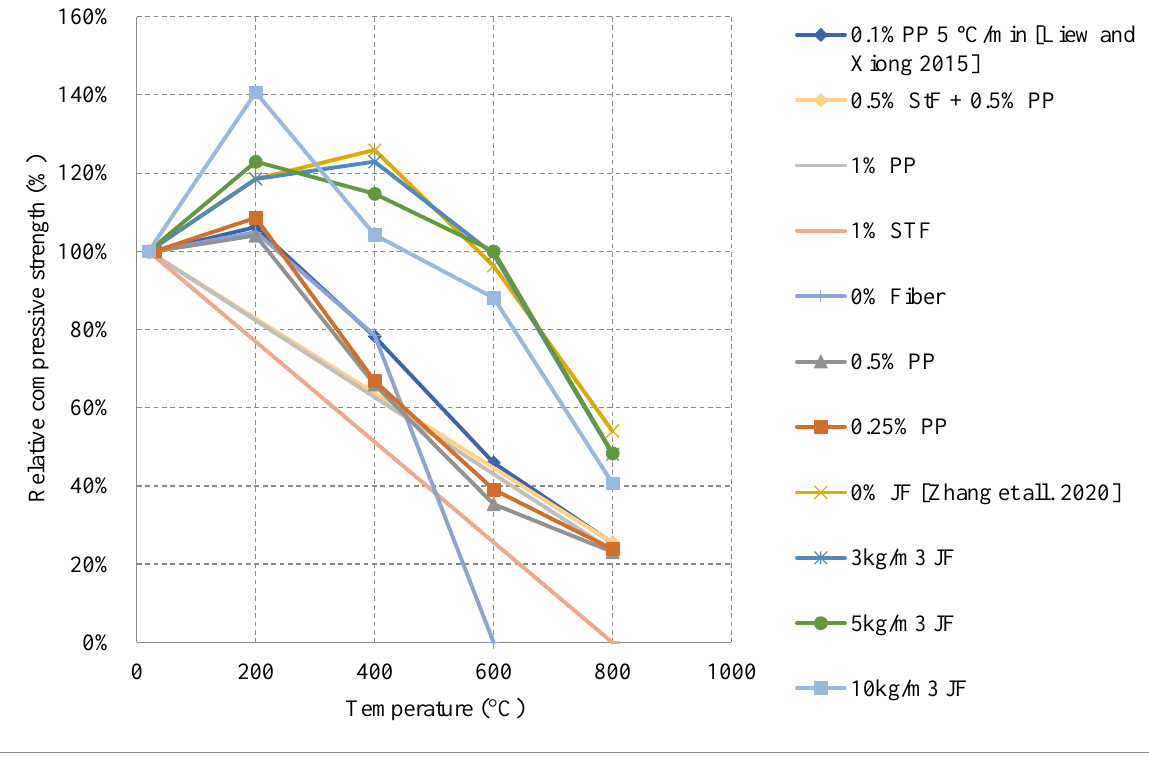
Figure 28. Relative compressive strength of furnace cooled UHPC with different constituents 2 [47,95].